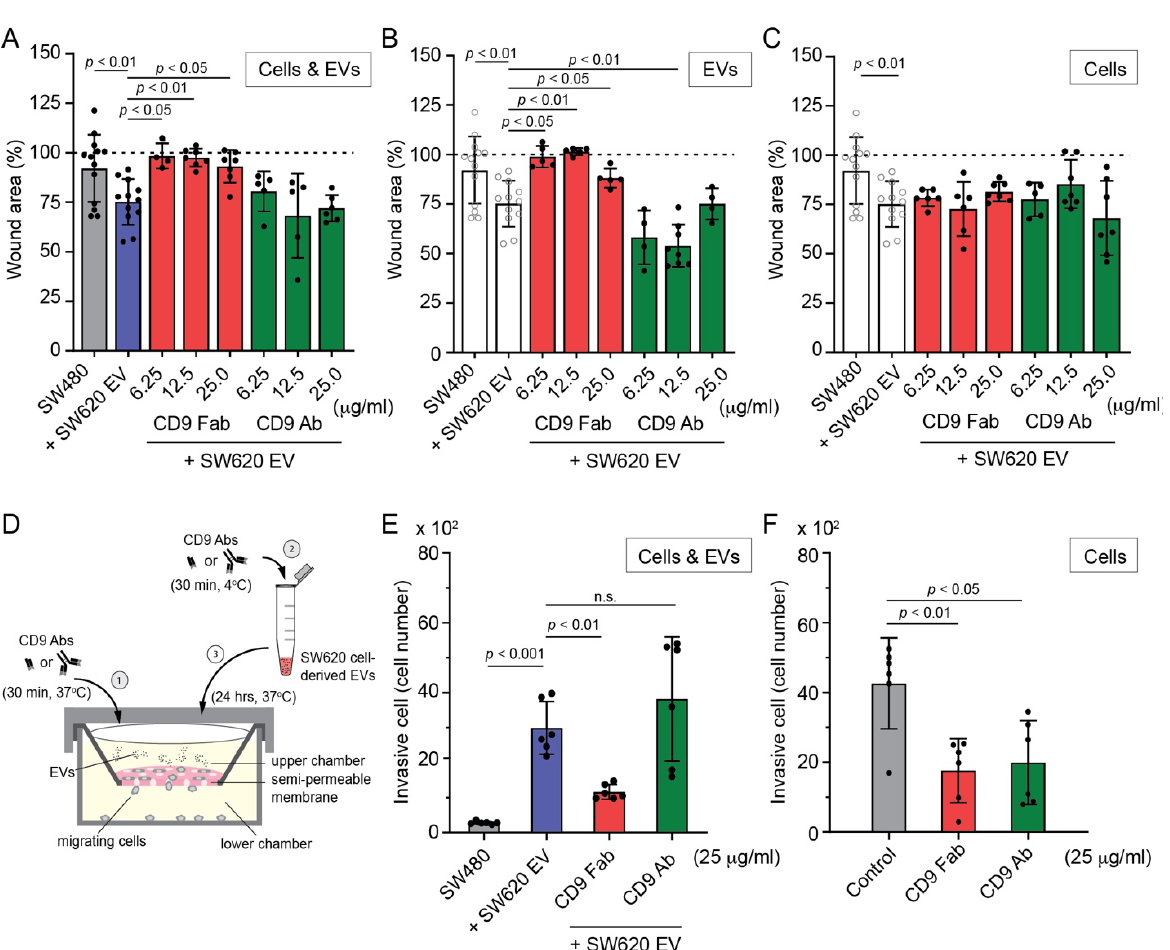
tility for SW480 cells primed by EVs (Figure 5E). The experiment was then repeated by